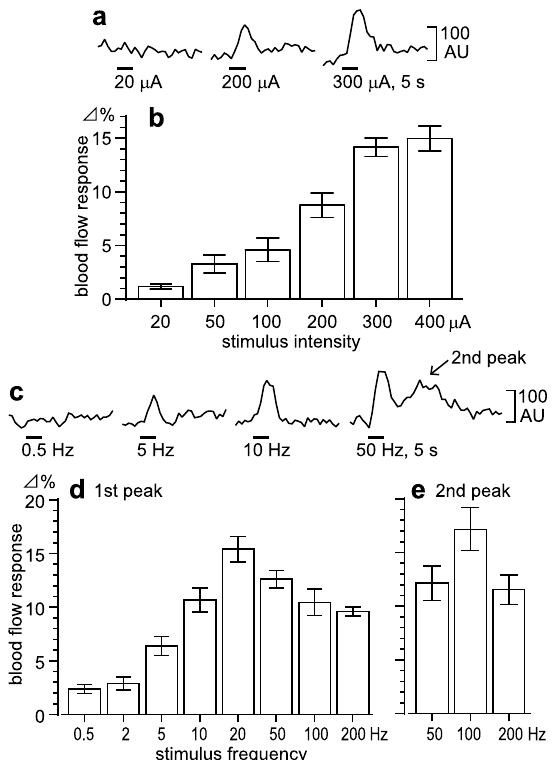
Fig. 2 Olfactory bulb blood flow responses to olfactory nerve stimulation in aged rats. The effects of various intensities ( a – b ) and frequencies ( c – e ) of electrical stimulation of the unilateral olfactory nerve on regional olfactory bulb blood flow on the side ipsilateral to the stimulus. a – b Stimulus frequency, 20 Hz. c Stimulus intensity, 400 μA. d – e Stimulus intensity, 300 or 400 μA. a, c Sample recordings of regional blood flow in the olfactory bulb. b, d, e Maximum levels of regional olfactory bulb blood flow. These occurred within 8 s (first peak) or 15–22 s (second peak) of stimulation onset. These are expressed as the percentage of the pre-stimulus basal blood flow (the mean of the values recorded in the 10 s before time zero), by which blood flow was increased. Each column and vertical